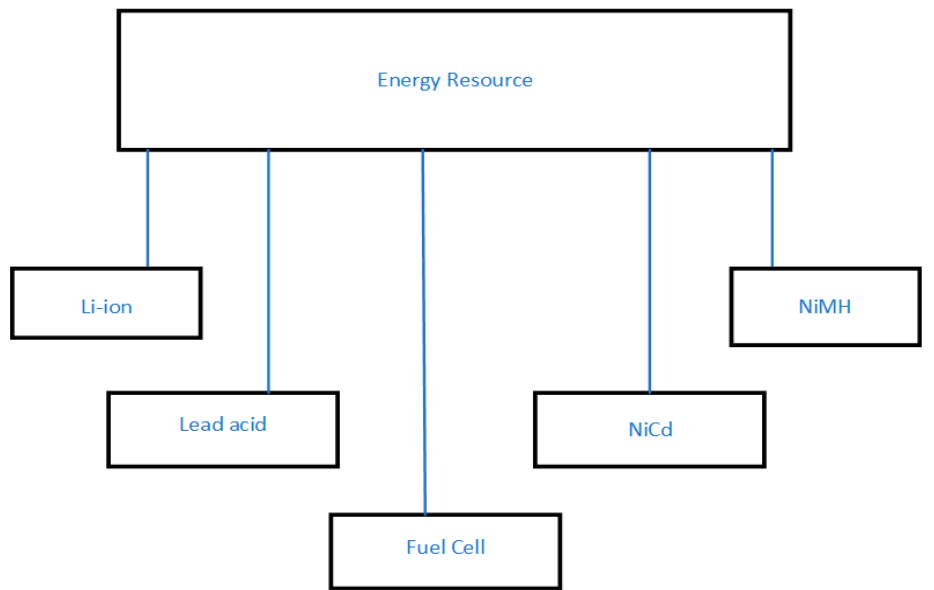
Figure 12. Categories of EV energy resources.